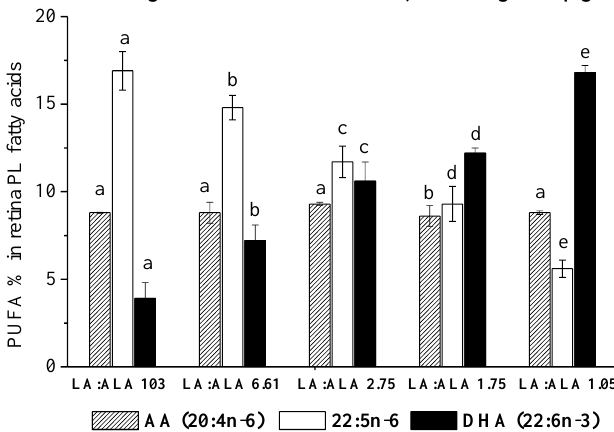
Figure 1. Effect of increasing dietary ALA on retina phospholipid proportions (mean ± SD) of selected PUFA (AA 20:4n-6), 22:5n-6 and DHA 22:6n-3) in 3-week-old guinea pigs whose mothers were maintained on these diets for the last one third of pregnancy. The number of animals in each group ranged from four to seven (see Table 1); the data with different letters for a particular fatty acid are significantly different ( p < 0.05). Table 1. Effect of increasing dietary ALA on retinal fatty acid proportions (g/100 g phospholipid fatty acids) a .